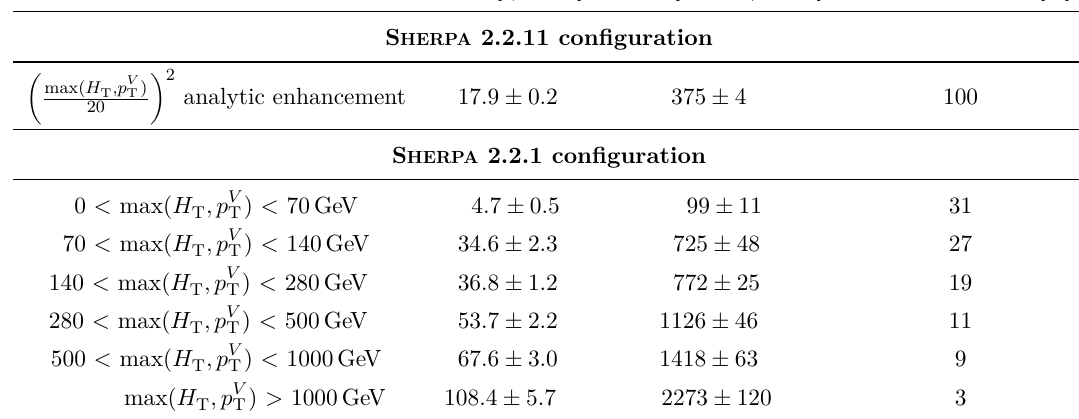
Table 3 . Mean CPU cost for the Sherpa configurations in seconds and HS06 seconds. The HS06 conversion factor used was 1 second = 20 . 97 HS06 seconds. The uncertainty corresponds to the standard deviation of multiple trials. The fraction of events corresponds to the number of events in a given slice to the total number generated across all